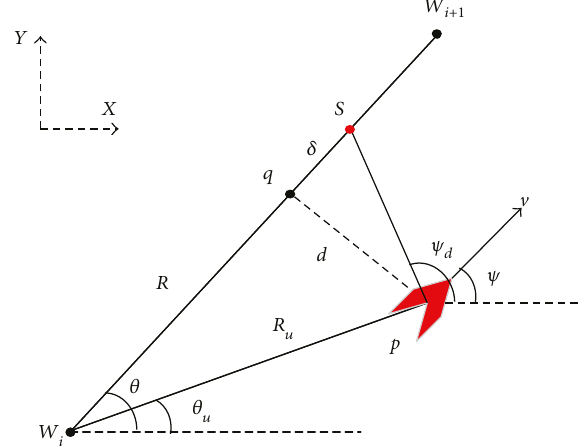
Figure 5: Straight line carrot-chasing schematics.